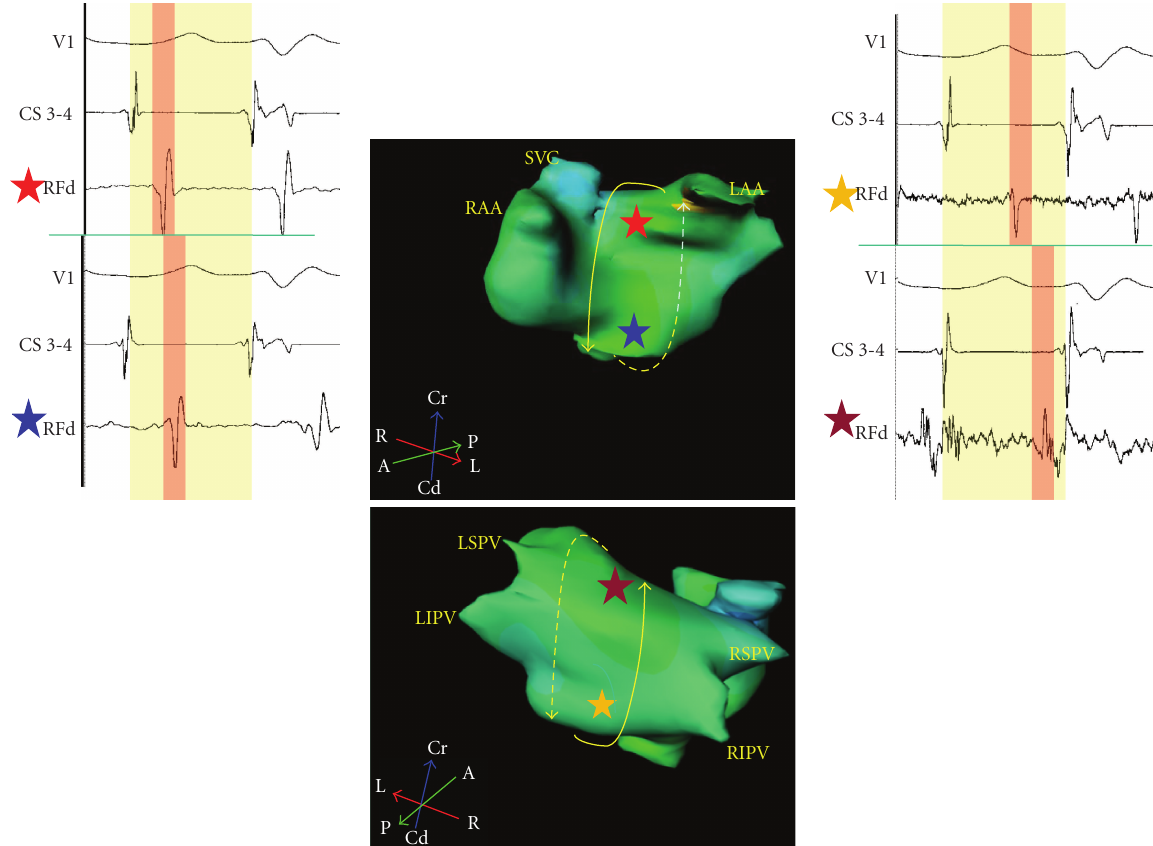
Figure 4: The electrogram recordings from four sites (red, blue, yellow, and maroon stars) on anterior and posterior left atrium are timed with coronary sinus dipole (CS 3-4) as reference. Local electrograms recorded from the high (red star) and low (blue star) anterior sites are 168 ms and 214 ms, respectively from the reference suggestive of high to low anterior left atrial activation pattern. Local electrograms recorded from high (maroon star) and low (yellow star) posterior sites are 274ms and 262 ms, respectively from the reference suggestive of low to high posterior left atrial activation pattern. This pattern is consistent with roof dependent